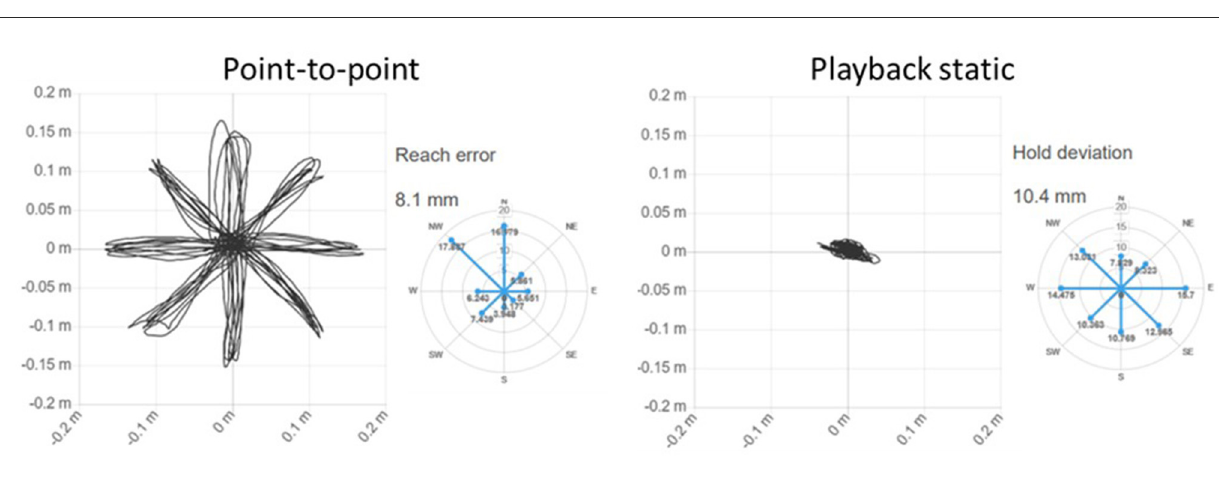
FIGURE4 Example of trajectories and indices of two